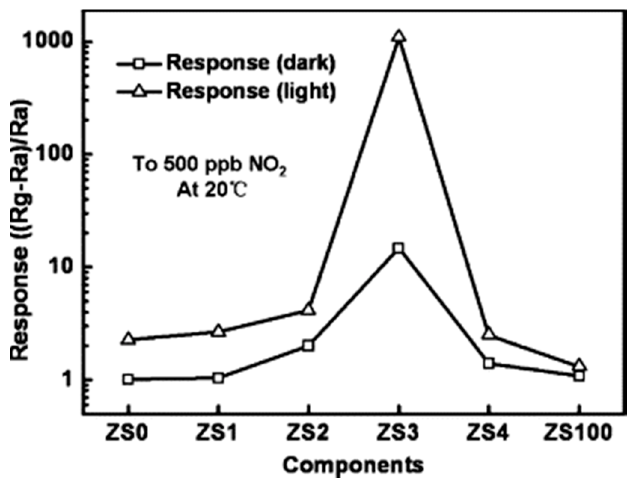
Figure 51. NO 2 sensing response at room temperature in dark and under UV light irradiation of ZnO/SnO 2 heterostructure with different ZnO: SnO 2 molar ratios. Reproduced with permission from [74].